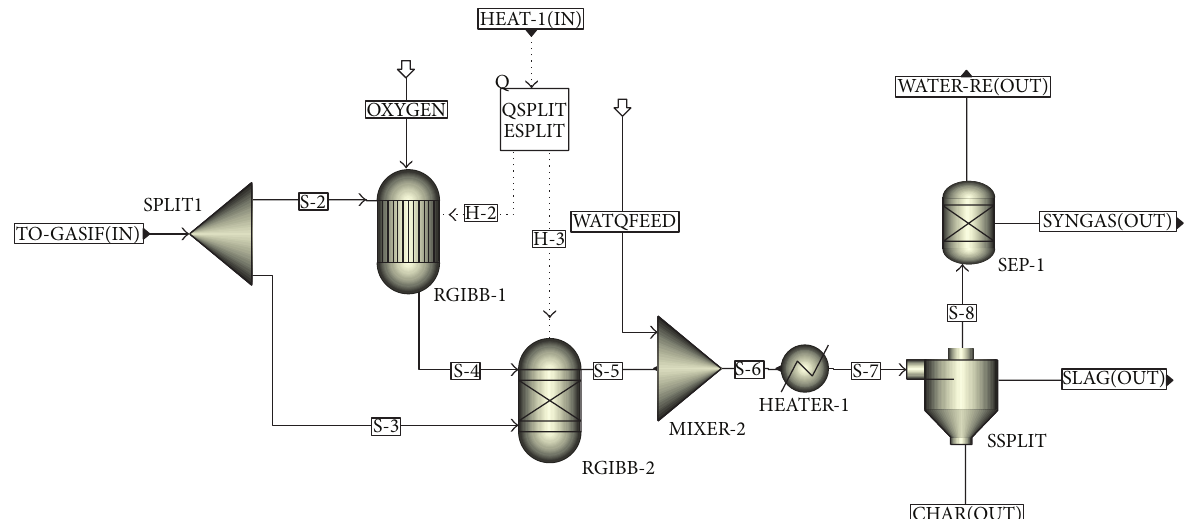
Figure 5: Aspen Plus GASIFIC hierarchy diagram to simulate the gasification stage of coal-SNG process. Flow sheet for the slurry feeding